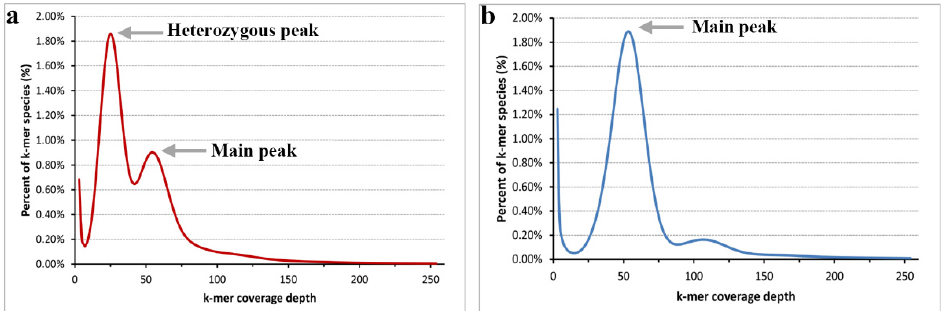
Figure 1. Distribution of the 17 -mer frequency. ( a ) the k -mer frequency distribution of the heterozy- gous parent; ( b ) the k -mer frequency distribution of the doubled haploid.